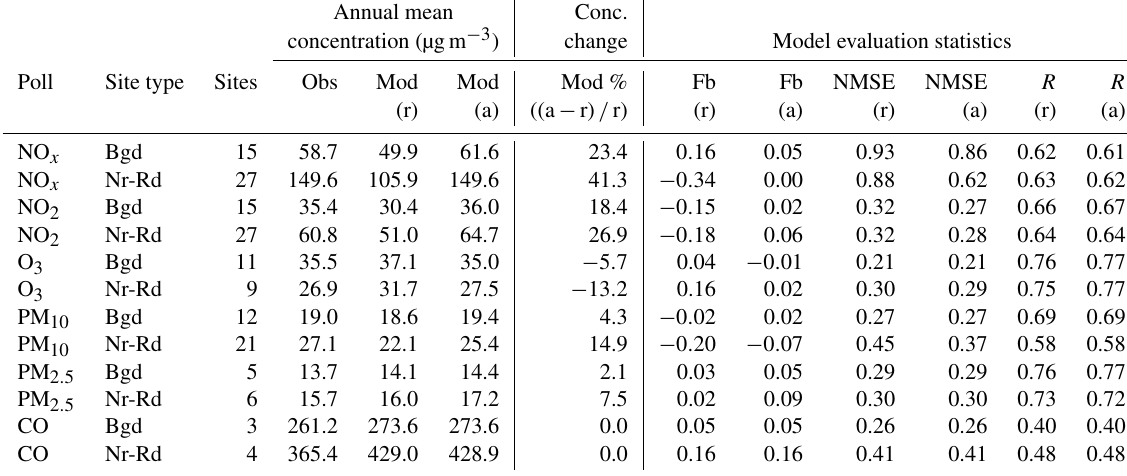
Table 3. Model evaluation statistics calculated from hourly average modelled and monitored concentrations for stand-alone ADMS-Urban runs with raw (r) and adjusted (a) road traffic NO x and PM emissions, and the % change in concentrations due to the emissions adjustment by site type Bgd (background) or Nr-Rd (near-road). Fb – fractional bias in annual average concentration, ideal value 0.0; NMSE –